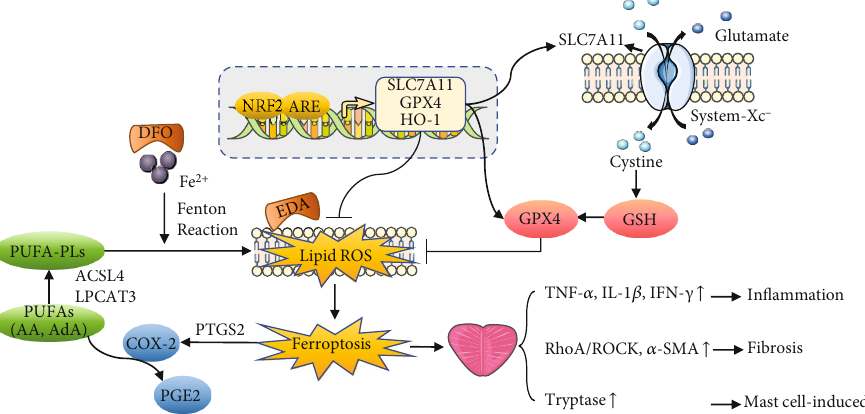
Figure 9: Summary of the mechanism of ferroptosis in chronic prostatitis. Cystine is intracellular transported through system Xc - and utilized for GSH synthesis, which is an essential cofactor of GPX4 for removing phospholipid hydroperoxides (PLOOHs). ACSL4 and LPCAT3 are involved in the esteri fi cation and incorporation process of PUFA into membrane lipid and thus served as the substrates of lipid peroxidation. Iron overload initiated the Fenton reaction to generate excessive lipid ROS, including PLOOH, through oxidizing PUFAs or PUFA-containing lipids. The excessive production of ROS and suppression of GPX4 reduced host defense against oxidative stress and thus mediated the onset of ferroptosis in prostatitis. Ferroptosis-associated cell breakdown brought the recruitment of macrophage cell, T cell, and mast cell, resulting in intensive in fl ammation and pain sensitization. The uncontrolled in fl ammatory response promotes the occurrence of oxidative damage and ferroptosis in a feedback manner and therefore causes persistent in fl ammation, fi brosis, and pain in patients with chronic prostatitis. NRF2 positively regulated antioxidant molecules (SLC7A11, GPX4, HO-1, etc.) to inhibit ferroptosis. Iron chelator DFO and free radical scavenger EDA prevent ferroptosis by reducing iron availability and lipid